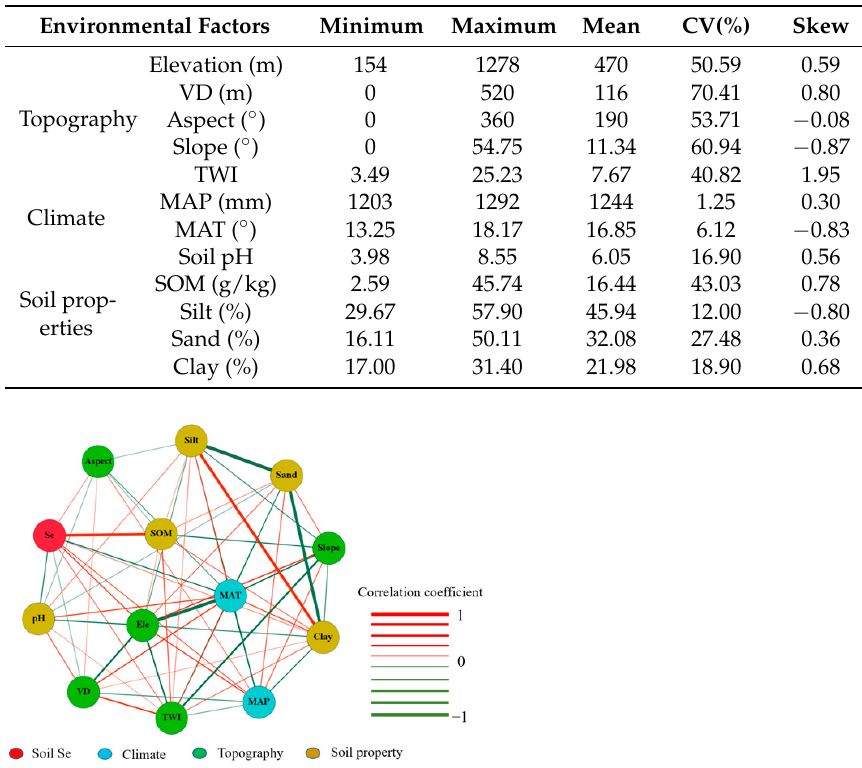
Figure 2. Basic statistics and sample distribution of soil Se content in Kaizhou. Table 2. The basic statistics of environmental factors. Table 2. The basic statistics of environmental factors.